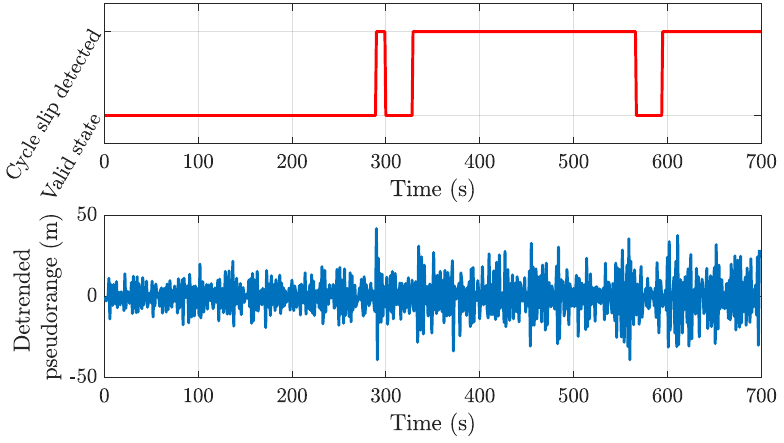
Figure 16. Effect of cycle slips in a real environment (PRN